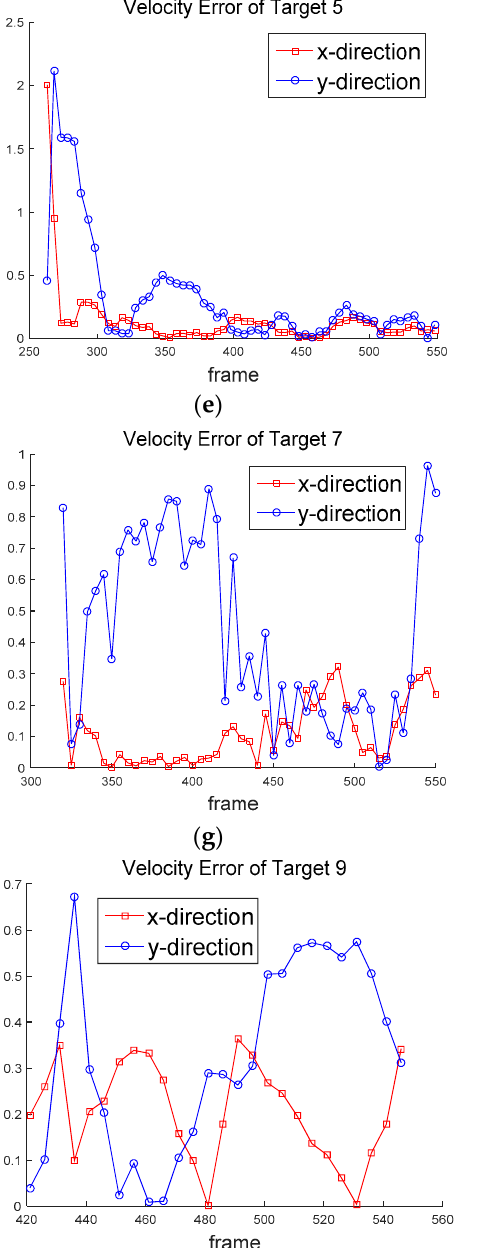
Table 3. Root-mean squared errors (RMSE) of position and velocity.